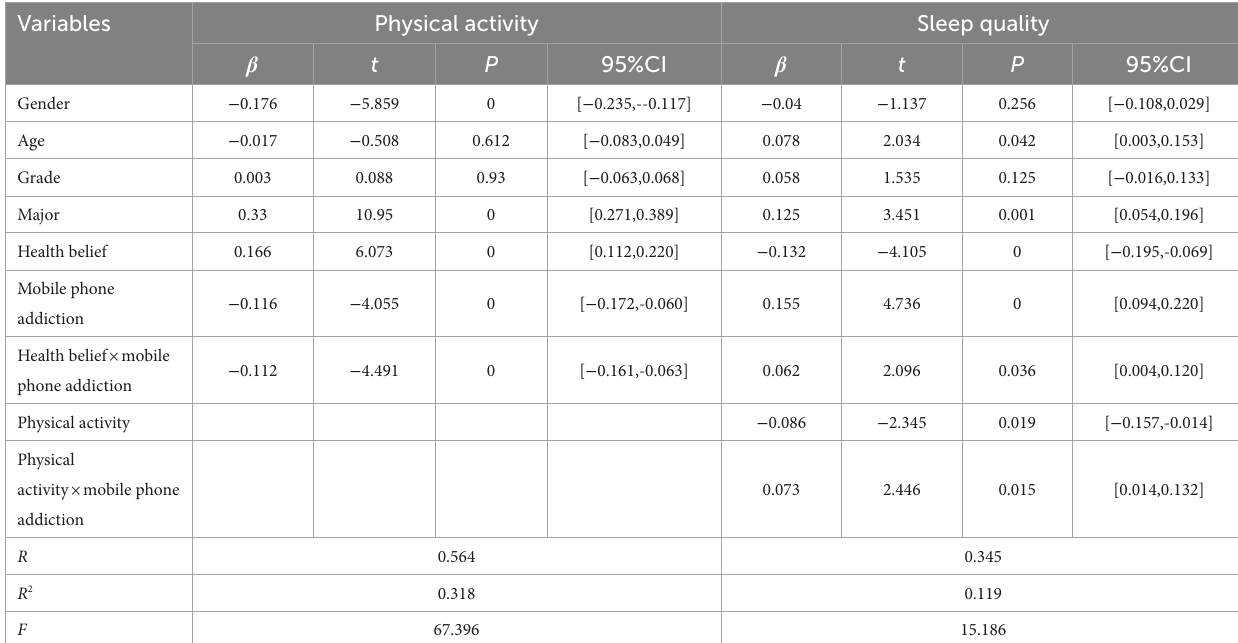
TABLE 5 Moderated mediation model